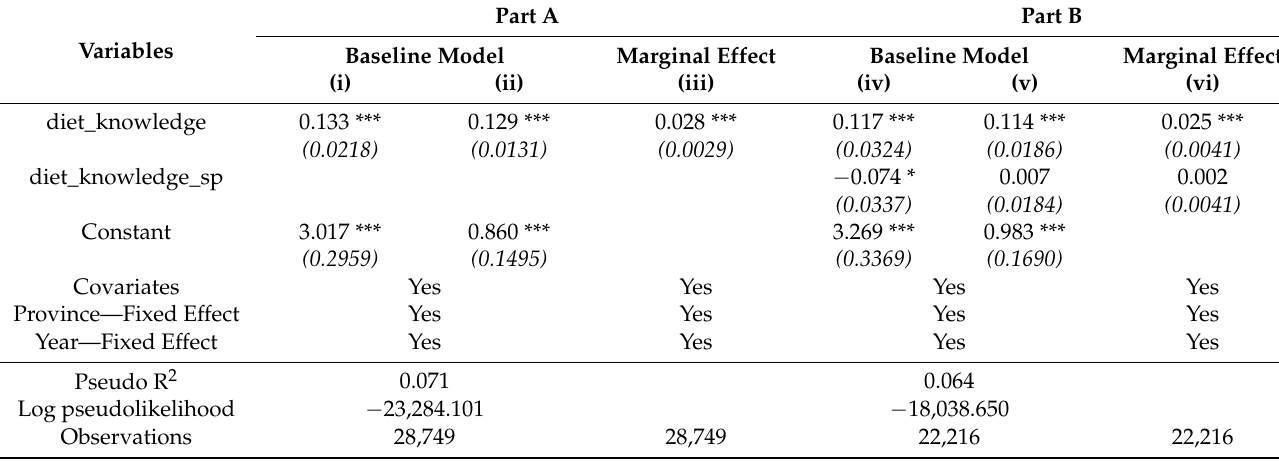
Table A2. Robustness check of the effect of dietary knowledge on health I (changing the calculation method of dietary